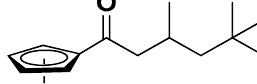
Figure 21. Ferrocene-modified pyrazole amino acids methyl esters, R = H (glycine) ( a ); Me (ala- nine-DL , L, D) ( b ); CH 2 Ph (phenyl alanine-DL, L, D) ( c ); Et (valine-DL, L, D) ( d ); CH 2 OH (ser- ine-DL, L) ( e ); 4-HOC 6 H 4 CH 2 (tyrosine-DL, L, D) ( f ); CH 2 -3-indole (tryptophan-DL, L) ( g ); proline (DL, L) ( h ); and Et ( α -amino butyric acid-DL, L, D) ( i ) [72].